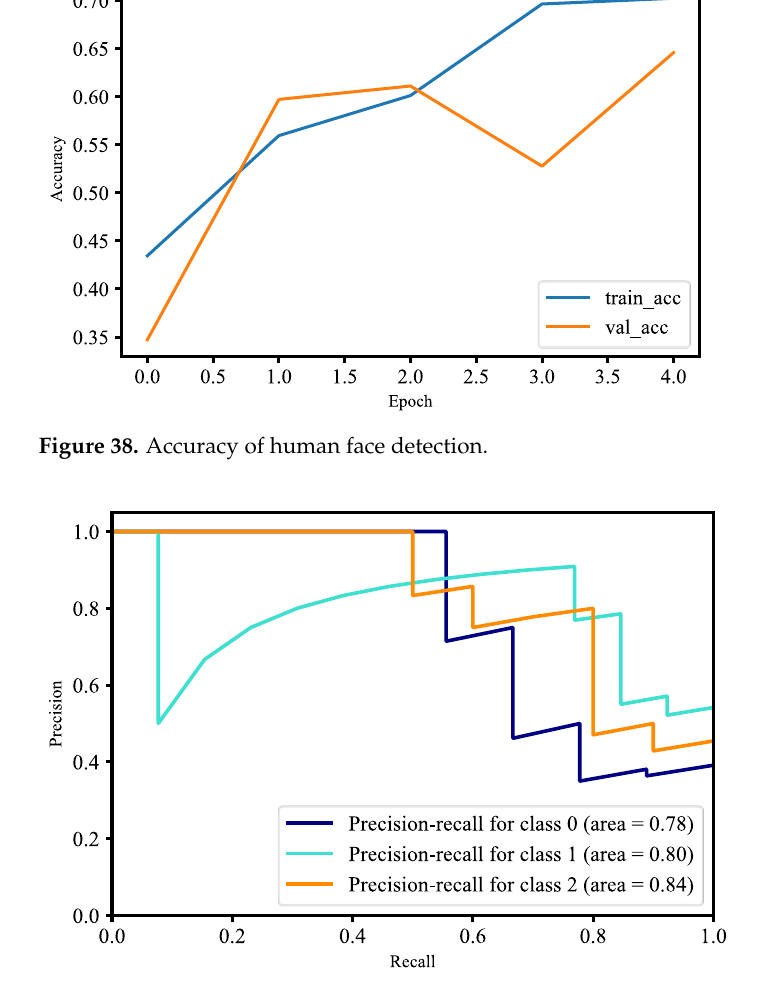
Figure 39. Multi-class P-R curve of human face detection.